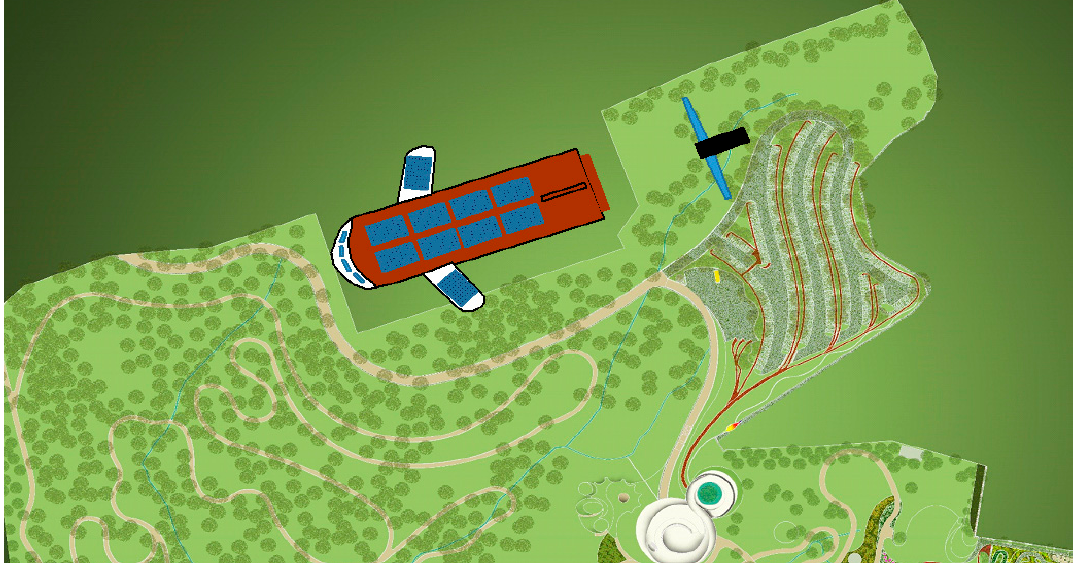
Figure 18. Preliminary outline of the organic construction type airplane.